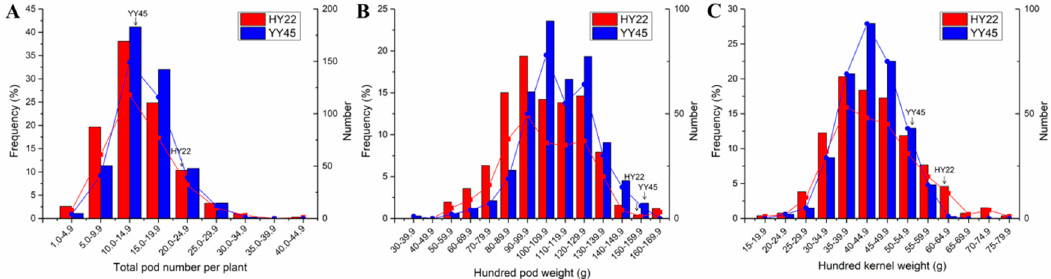
Figure 4. Frequency and number distribution of yield traits of M2 generation of HY22 and YY45 induced by EMS treatments. ( A ) Total pod number per plant; ( B ) Hundred pod weight; ( C ) Hundred kernel weight.